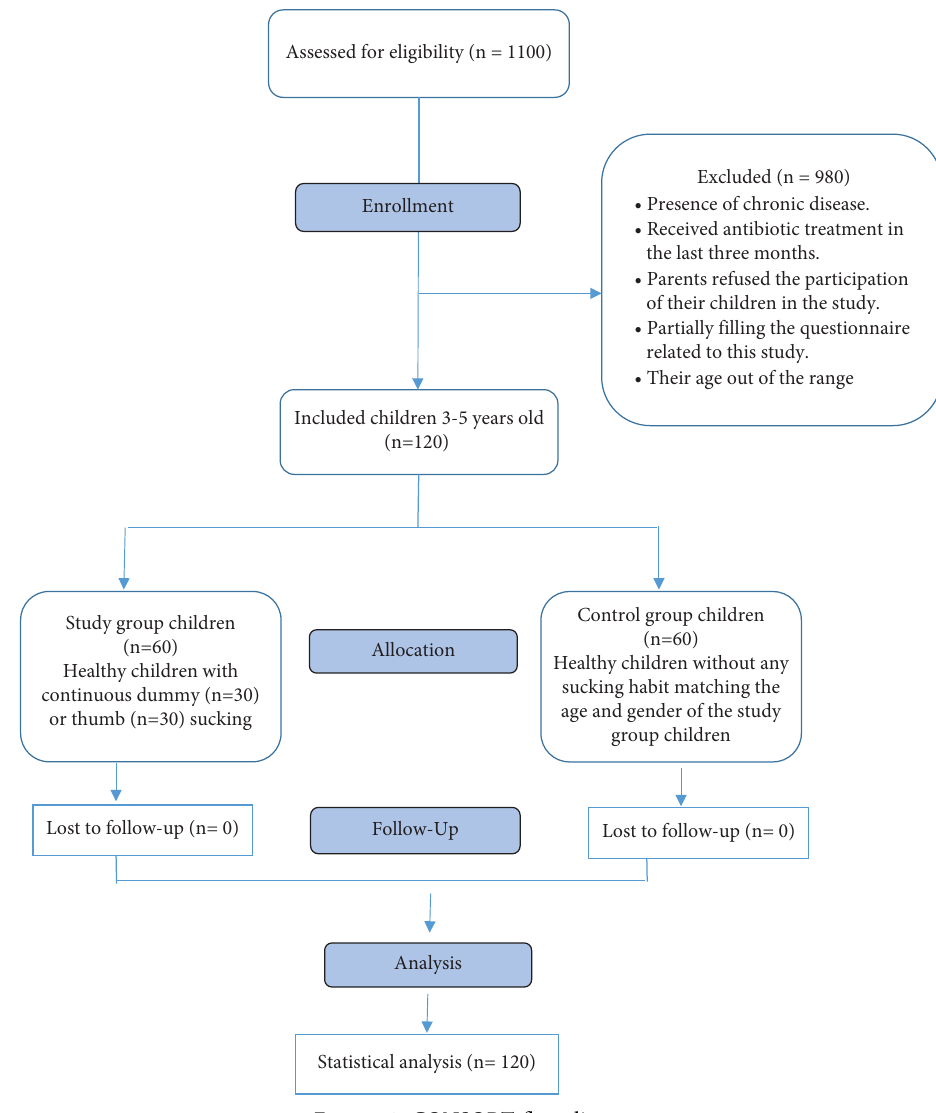
Figure 1: CONSORT fow diagram. Table 1: Mean E. coli count between the nonnutritive sucking habit group and those without any sucking habit according to age and gender. E. coli Variables